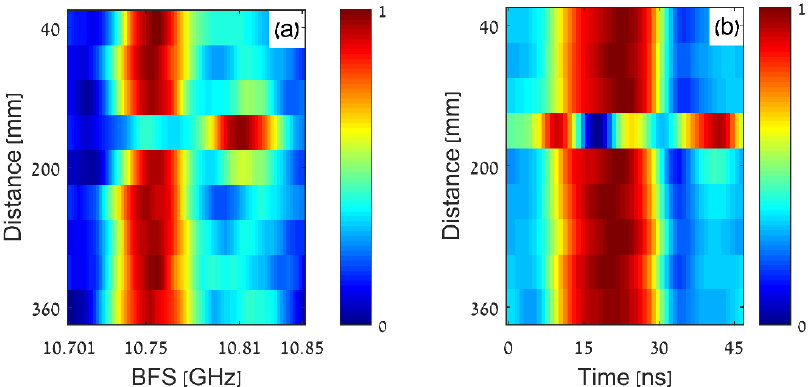
Figure 8. ( a ) Measured normalized steady-state Brillouin gain as a function of correlation peak position and frequency offset between pump and signal waves in a phase-coded B-OCDA experiment over 360 mm of fiber [24]. A 4-cm-wide segment 160 mm from the input end was locally heated. ( b ) Measured normalized transient Brillouin gain of the same fiber as a function of correlation peak position and time [24]. The frequency offset Ω was arbitrarily chosen as 2 π × 10.733 GHz. Reproduced with permission from [24], Optical Society of America,